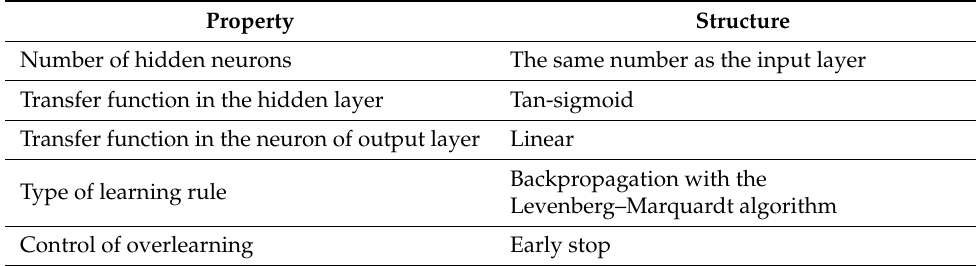
Table A2. Comparison of the performance of the ANNs, SLRs and QRs for the dataset with transaction prices. Performance